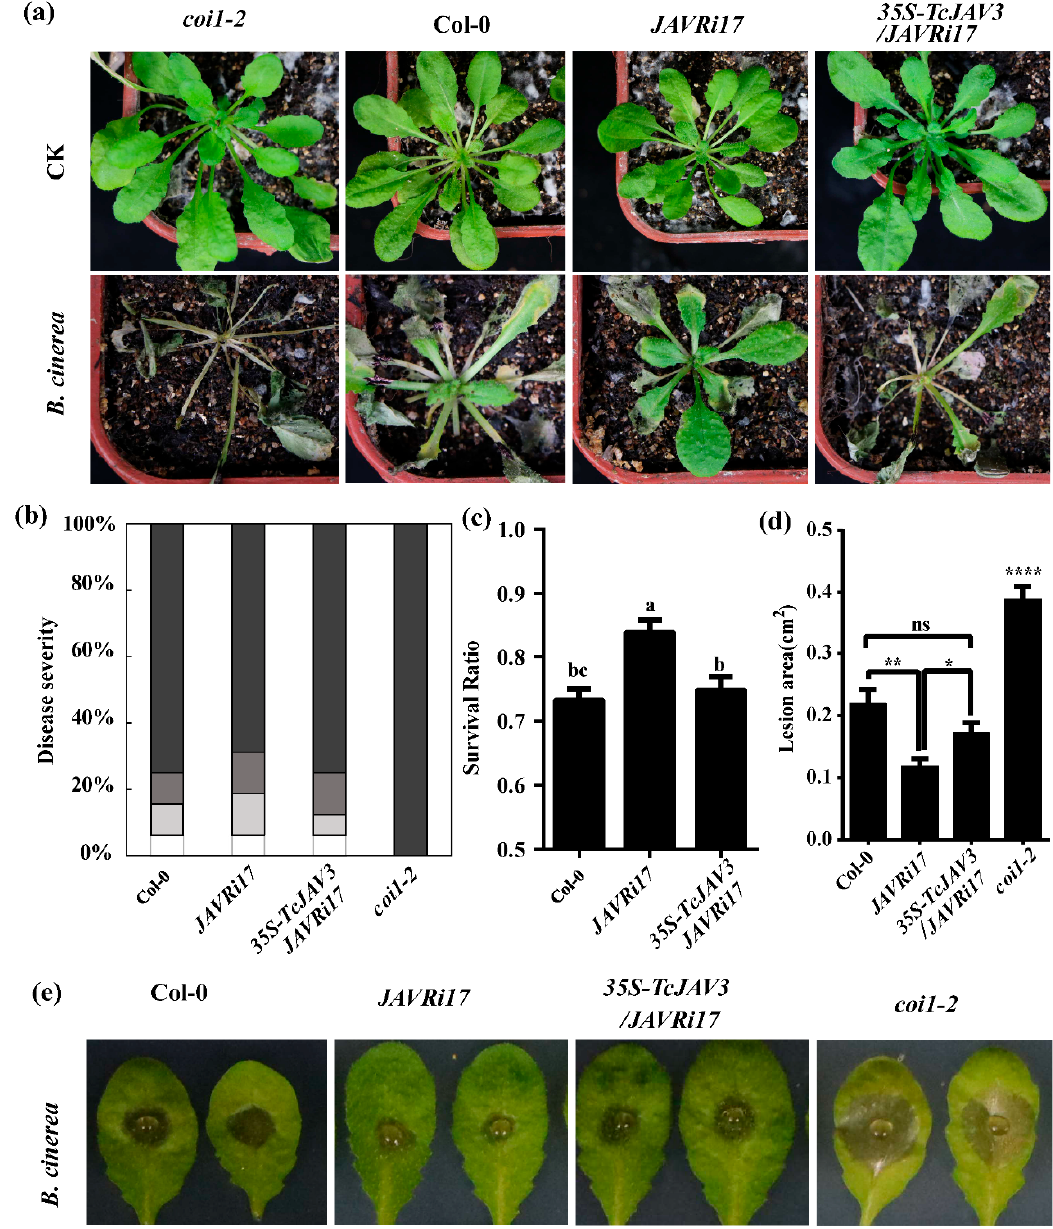
Figure 2. Disease-resistance phenotype in TcJAV3 complement Arabidopsis line. ( a ) The phenotypes of coi1-2 , WT (col-0), AtJAV1 RNAi transgenic plants ( JAVRi17 ), and TcJAV3 complement plants ( 35S-TcJAV3/JAVRi17 ) 7 days after spray inoculation with B. cinerea or water (CK). ( b ) Disease severity of the plants indicated in ( a ). The darker bars indicate the percentage of leaves with severe disease symptoms; the white or light gray bars indicate weak symptoms or no visible symptoms. ( c ) Survival percentage of the plants indicated in ( a ) (mean ± SEM; n = 12; statistics by one-way ANNOVA Duncan test). Bars with the different letter are significantly different from one another, p < 0.05. ( d ) Necrotic lesion area in each leaf described in ( e ) (mean ± SEM; n = 12; statistics by t test; * p < 0.01, ** p < 0.01, and **** p < 0.001). ( e ) The phenotypes of the leaves from WT, coi1 , JAVRi17 , and 35S-TcJAV3/JAVRi17 at 48 h after drop inoculation with 5 µL spore suspension of B. cinerea or with water (CK).